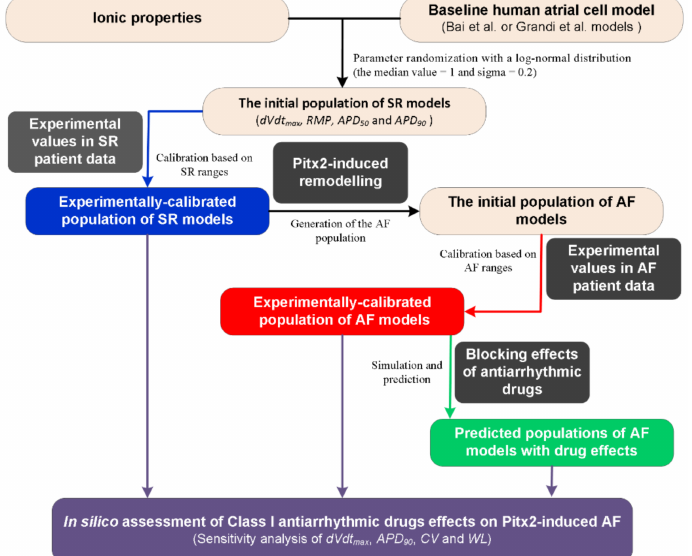
Figure 1. A flow chart illustrating the process for in silico assessment of class I antiarrhythmic drug effects on Pitx2 -induced atrial fibrillation (AF). Note: There are two distinct morphological subtypes of human atrial action potential (AP) [58] and therefore the Bai et al. model with a notch-and-dome AP morphology [27] and the Grandi et al. model with a triangular AP shape [59] were used in the present study. Class I antiarrhythmic drugs assessed include quinidine, disopyramide, and propafenone. Abbreviations: Pitx2 : Homeodomain transcription factor 2, SR: Sinus rhythm; dVdt max